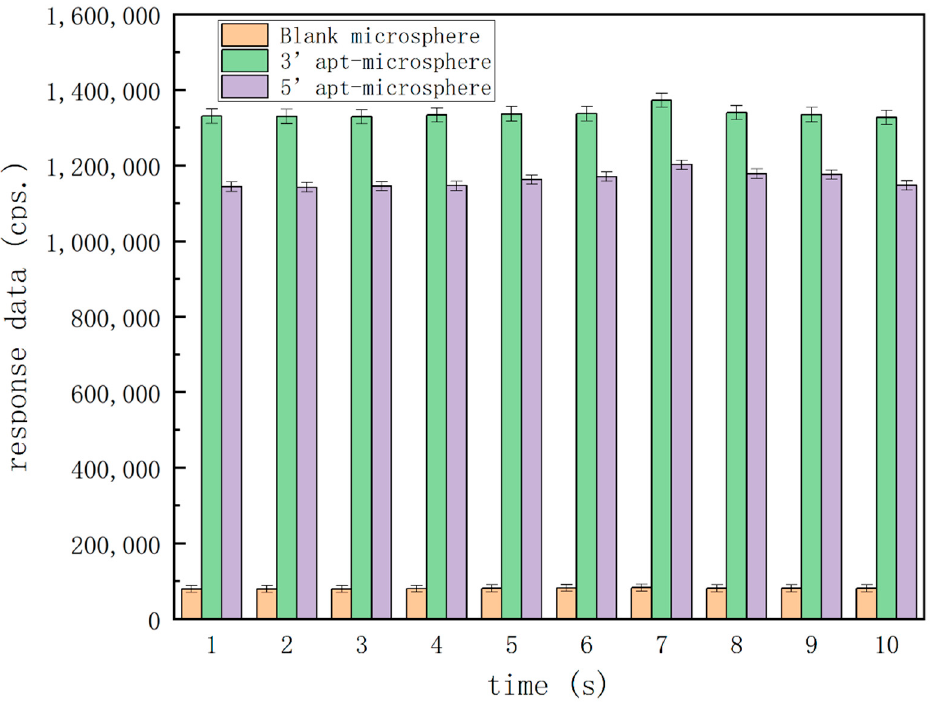
Figure 3. Confirmatory analysis of the immobilization of aptamers on microspheres.